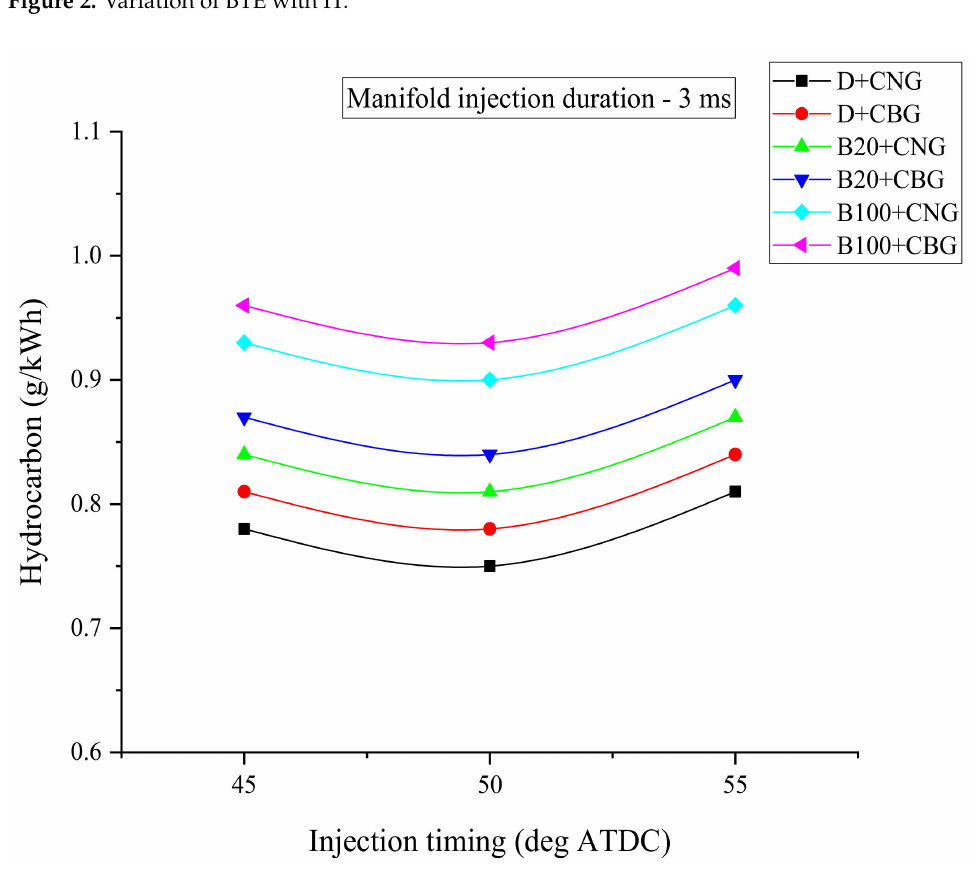
Figure 3. Variation of HC emissions with